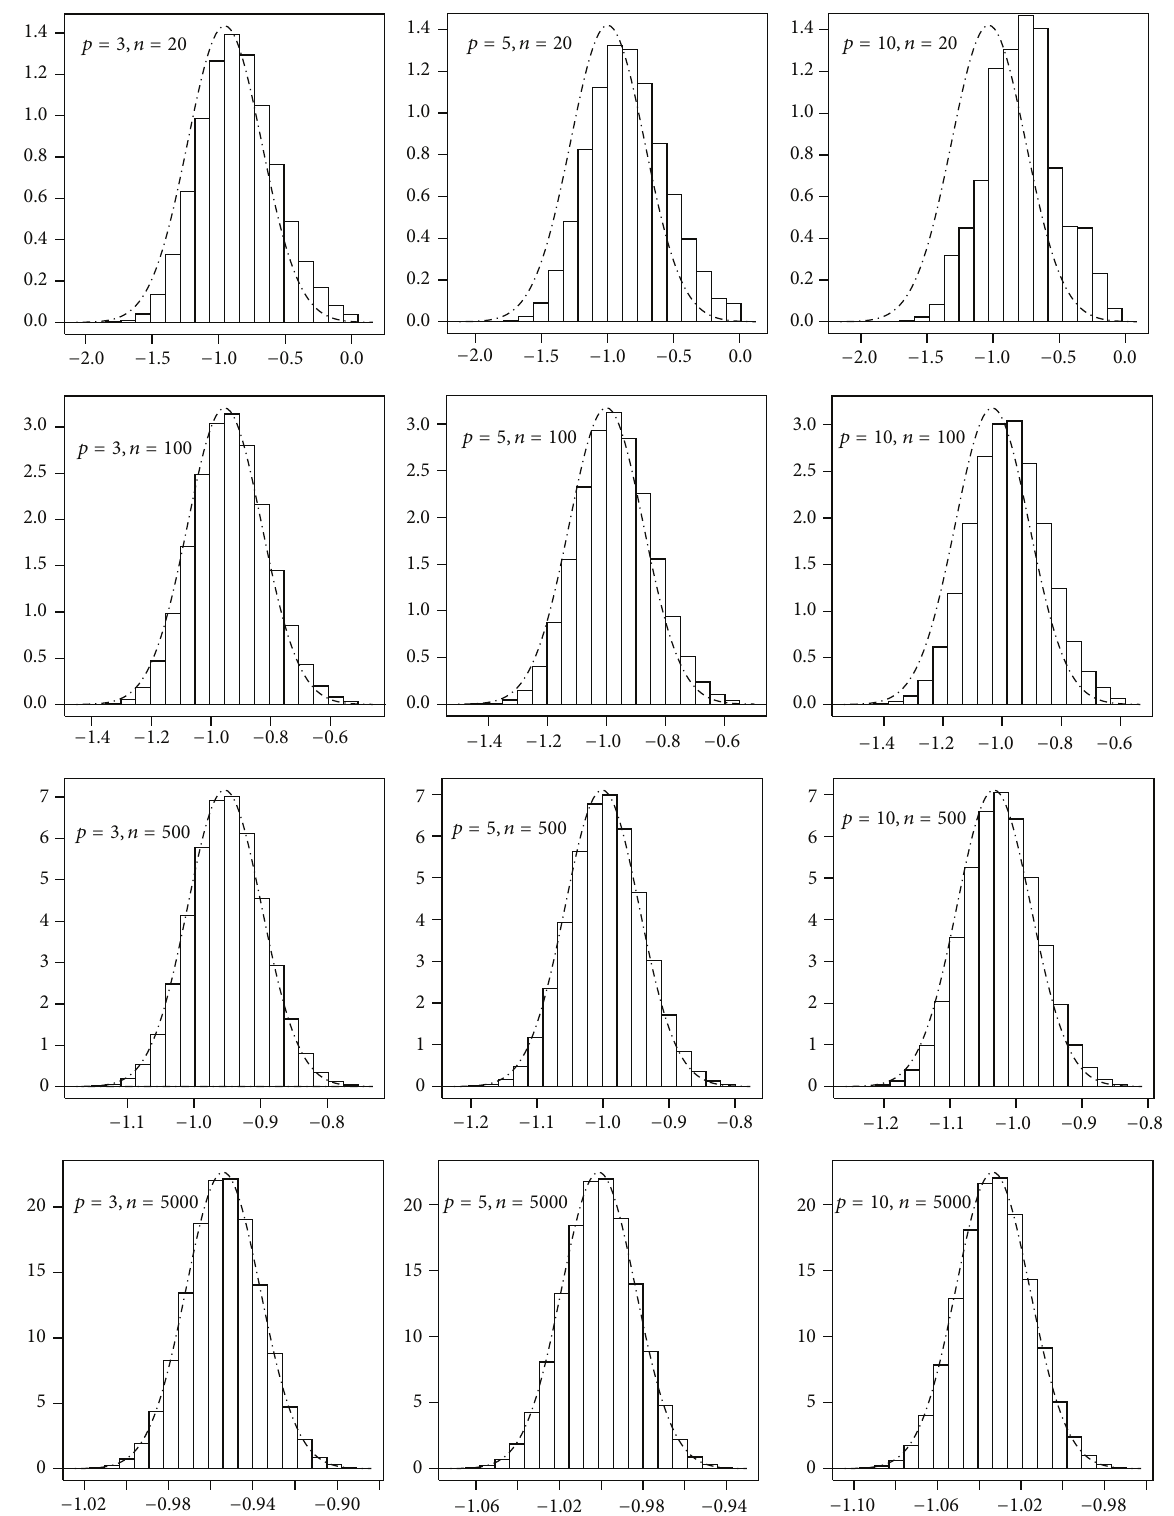
Figure 1: Comparison of the approximate likelihood (normalized) with the exact likelihood (normalized) for covariance matrices of dimensions 𝑝 = 3, 5, and 10, and sample sizes 𝑛 = 20, 100, 500, and 5000. The histogram is the normalized likelihood and the dashed curve is the approximate normalized